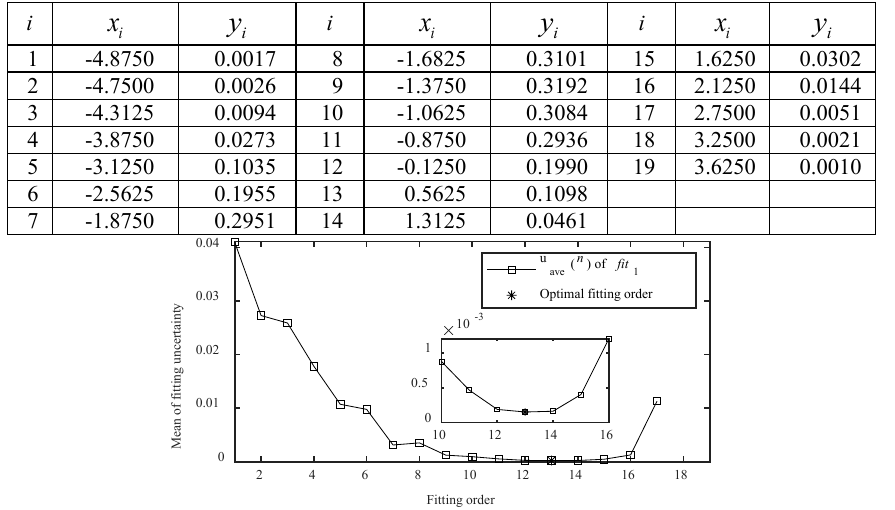
Table 3. First-order Tracy-Widom distribution PDF fitted data points.